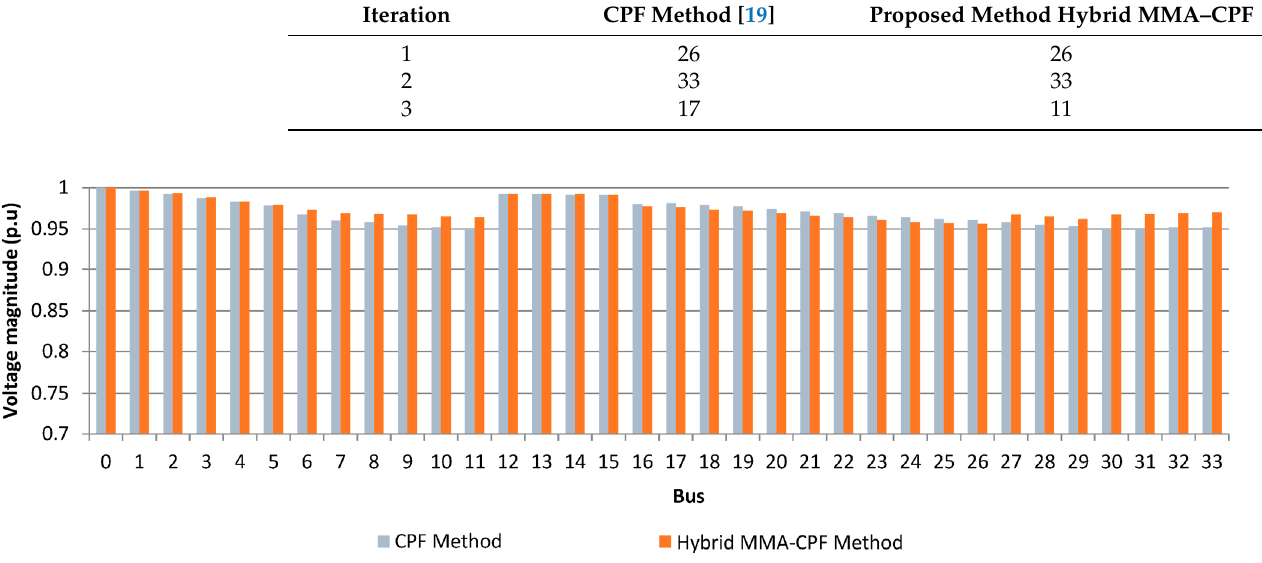
Figure 13. Voltage magnitude after DER integration with the CPF method and the proposed hybrid method.